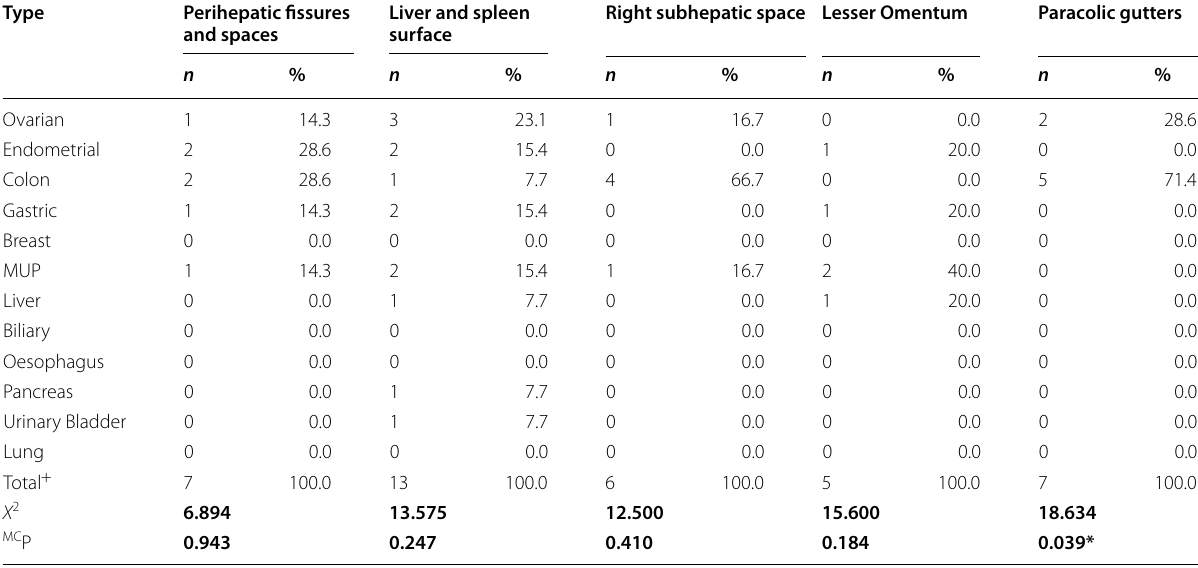
Bold indicates X 2 : Chi-square test, MC: Monte Carlo exact test Data expressed as frequency ( n and %); MUP Metastases of unknown primary; + Most of the included patients showed more than one site of peritoneal metastasis; p probability; *, significance < 0.05